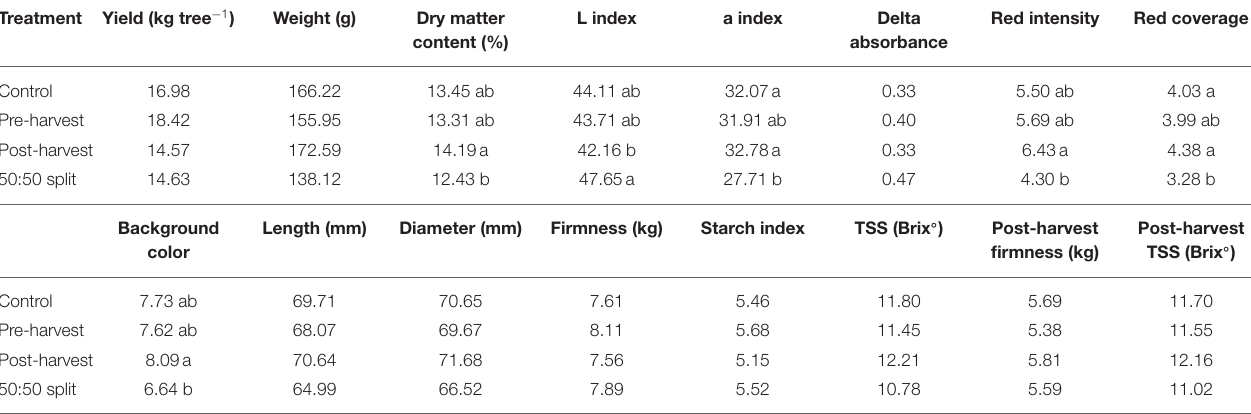
TABLE 3A | Fruit yield and quality parameters at fruit harvest and post-harvest in 2017–2018 season under the impact of different N fertigation timings. Within each parameter, different letters indicate significant differences ( p < 0.05) between treatment means ( n = 4). Treatment Yield (kg tree − 1 )